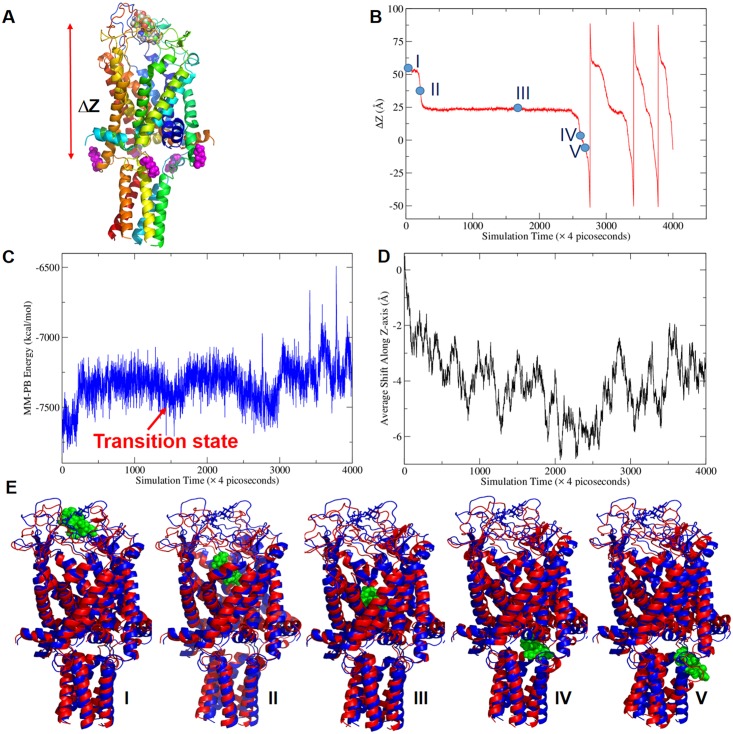
Molecular dynamic simulation of DHS passing through the Ec-MscL channel with an EEF of 0.2 volt/Å applied to DHS.(A) ΔZ is defined as the Z coordinate difference of two geometrical centers of DHS and five K106 LYS residues (monomer 1: K106; monomer 2: K242; monomer 3: K378; monomer 4: K514, and monomer 5: K650) which are K106 in monomer labeling. If DHS is located in or above the plane formed by the five LYS, ΔZ > = 0, otherwise ΔZ < 0. (B) The ΔZ plot of DHS passing through Ec-MscL. Five representative conformations labeled as I, II, III, IV, and V, were selected for structural analysis. (C) The fluctuation of the MM-PB energy of Ec-MscL/DHS along the MD simulation trajectory of the passing-through event. (D) The average shifts along Z-axis of 95 K+ during the MD simulation. The negative displacements imply ions go towards outside of the membrane. (E) Representative conformations of the five stages of DHS passing through the Ec-MscL channel event superposed to the last snapshot of the ligand-free MD simulation. DHS is shown as green balls. The reference structure in blue representation is a closed conformation. All the representative conformations of the five passing-through stages are shown as red ribbons. From Conformations I to V, the C-terminal helixes and TM1 are deformed progressively, while no significant difference is observed for S1 and TM2.